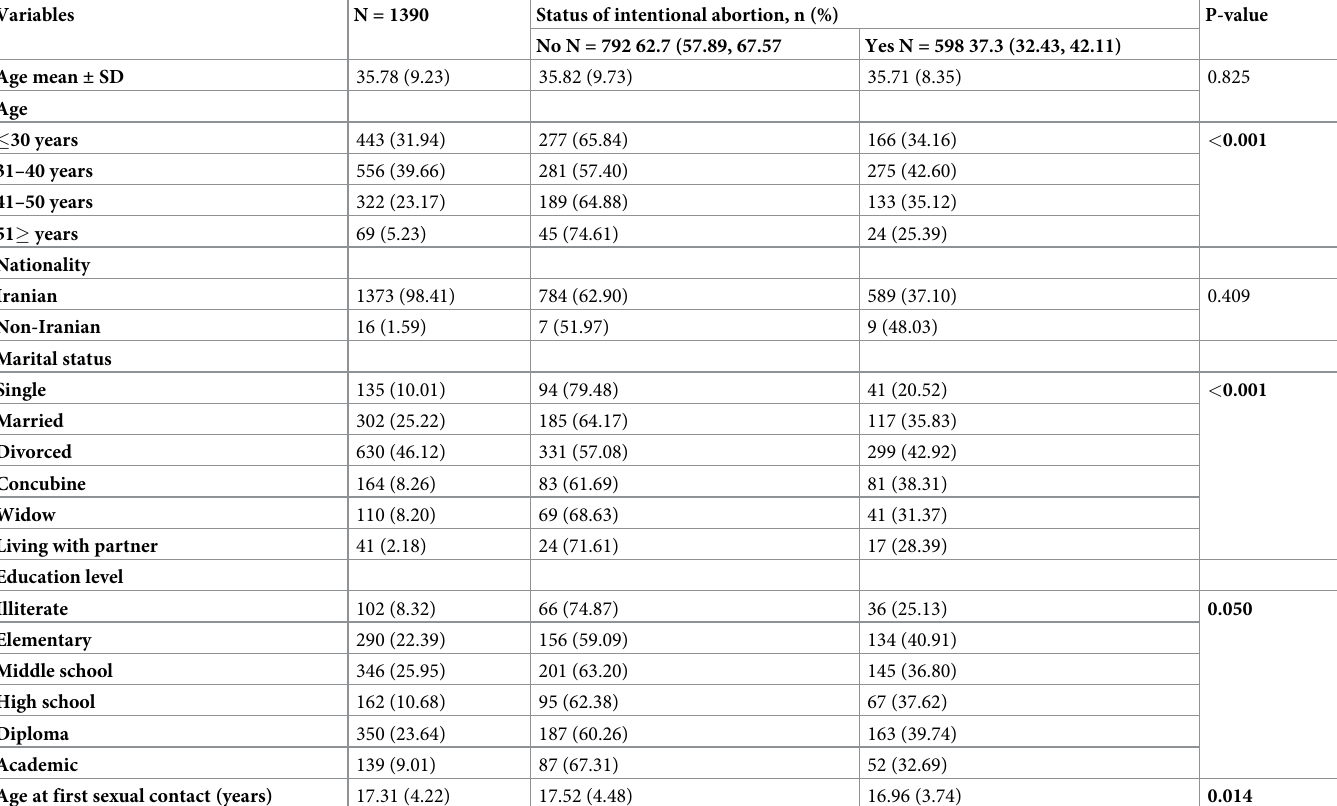
Table 1. Demographic characteristics and intentional abortion among female sex workers in